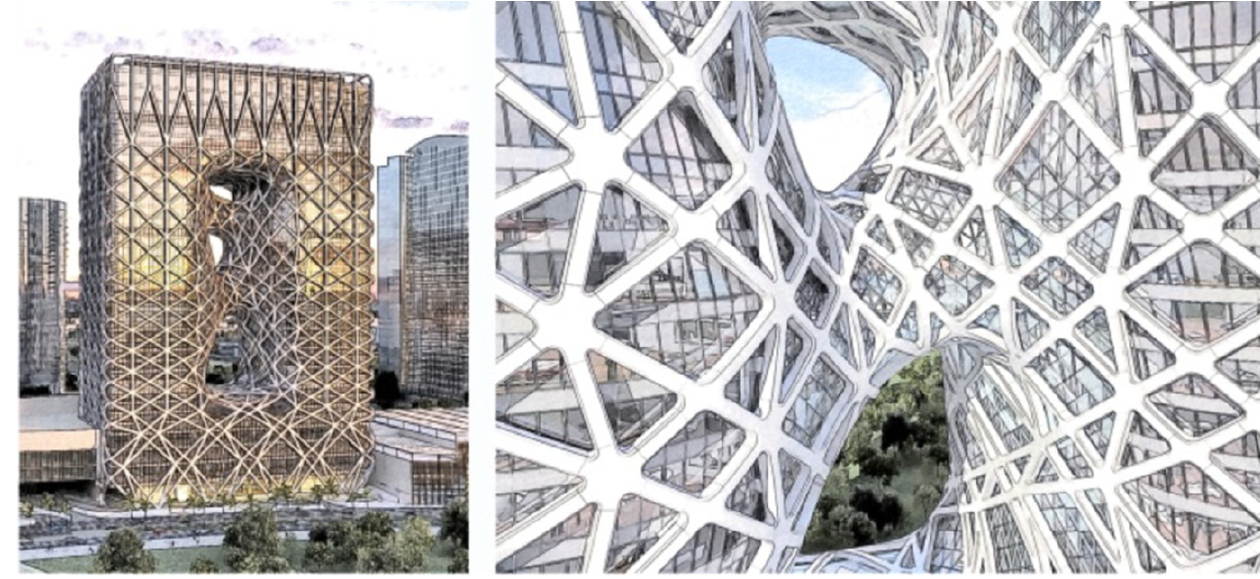
Figure 26. Morpheus Hotel (2018) at City of Dreams in Macau, China by Zaha Hadid. It is an example of an “exotic” diagrid structure. The right image zooms in on the dynamic portion of the diagrid. (Sketch by K.